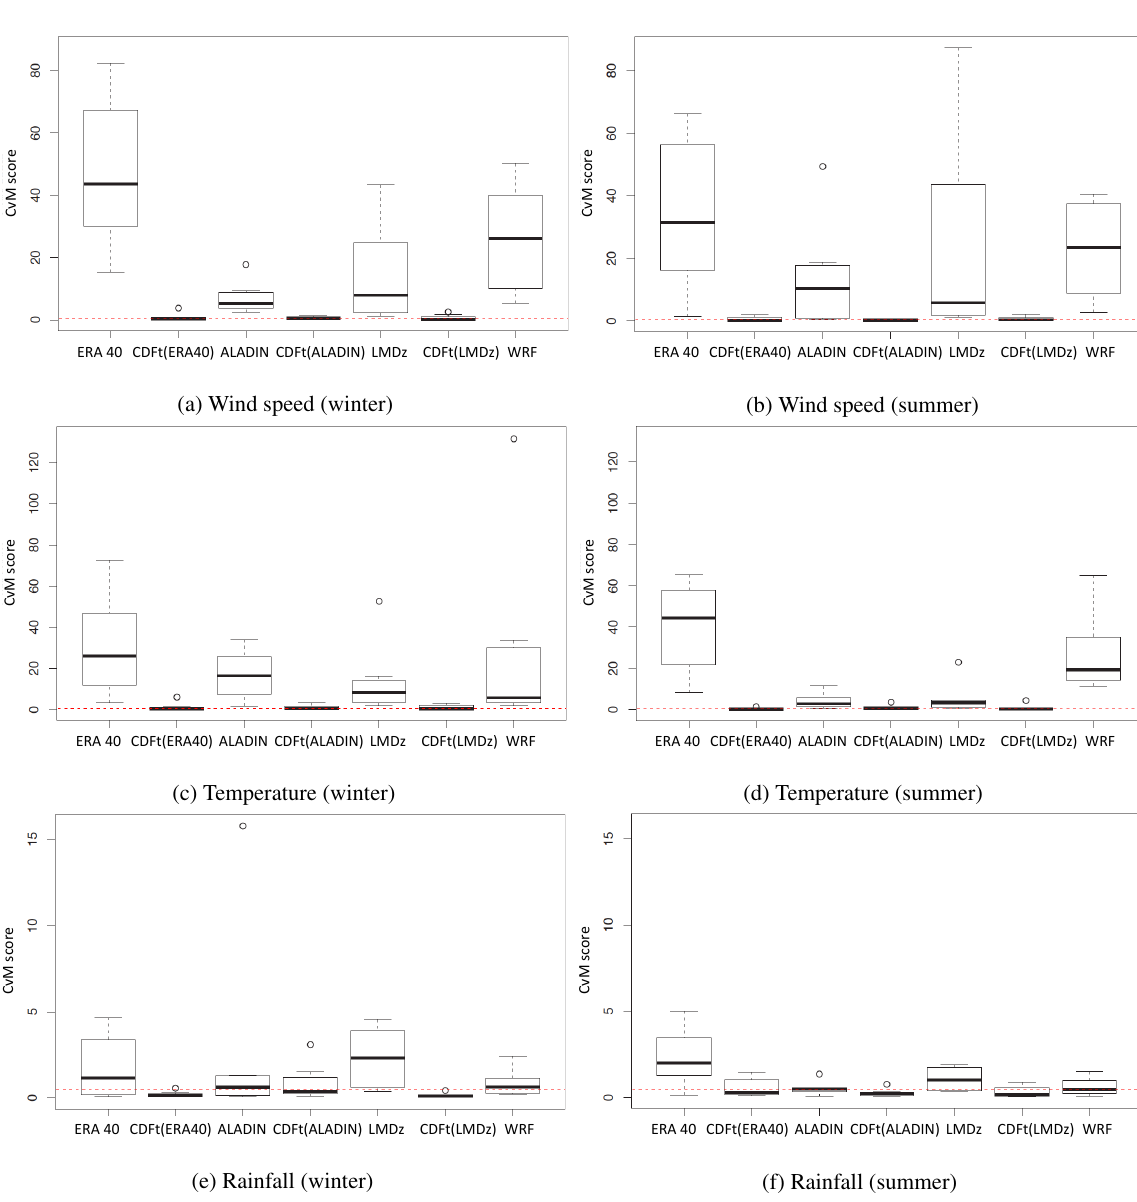
Fig. 2. Boxplots of Cramer-von Mises (CvM) scores computed over the evaluation period (1996–2000 for wind, and 1991–2000 for tem- perature and rain) in winter (left column) and summer (right column). The dashed lines indicate the threshold CvM values under which the Fig. 2: Boxplots of Cramer-von Mises (CvM) scores computed over the evaluation period (1996-2000 for wind, and 1991-2000 Fig. 2: Boxplots of Cramer-von Mises (CvM) scores computed over the evaluation period (1996-2000 for wind, and 1991-2000 modelled CDFs (from ERA-40, RCMs or CDF-t) are not statistically significantly different at 95% from the CDF of the observations. Fig. 2: Boxplots of Cramer-von Mises (CvM) scores computed over the evaluation period (1996-2000 for wind, and 1991-2000 Fig. 2: Boxplots of Cramer-von Mises (CvM) scores computed over the evaluation period (1996-2000 for wind, and 1991-2000 for temperature and rain) in winter (left column) and summer (right column). The dashed lines indicate the threshold CvM for temperature and rain) in winter (left column) and summer (right column). The dashed lines indicate the threshold CvM Fig. 2: Boxplots of Cramer-von Mises (CvM) scores computed over the evaluation period (1996-2000 for wind, and 1991-2000 Fig. 2: Boxplots of Cramer-von Mises (CvM) scores computed over the evaluation period (1996-2000 for wind, and 1991-2000 for temperature and rain) in winter (left column) and summer (right column). The dashed lines indicate the threshold CvM for temperature and rain) in winter (left column) and summer (right column). The dashed lines indicate the threshold CvM ALADIN provide lower CvM scores for precipitation than different from the observations), the three RCMs have their values under which the modeled CDFs (from ERA40, RCMs or CDF-t) are not statistically significantly different at 95% from values under which the modeled CDFs (from ERA40, RCMs or CDF-t) are not statistically significantly different at 95% from for temperature and rain) in winter (left column) and summer (right column). The dashed lines indicate the threshold CvM for temperature and rain) in winter (left column) and summer (right column). The dashed lines indicate the threshold CvM boxplots higher than the theoretical thresholds for both sea- for the other variables and all models perform better than values under which the modeled CDFs (from ERA40, RCMs or CDF-t) are not statistically significantly different at 95% from values under which the modeled CDFs (from ERA40, RCMs or CDF-t) are not statistically significantly different at 95% from sons (first two rows of Fig. 2). For rainfall, CvM scores from ERA-40 for both seasons and variables (except LMDZ win- the CDF of the observations. the CDF of the observations. values under which the modeled CDFs (from ERA40, RCMs or CDF-t) are not statistically significantly different at 95% from values under which the modeled CDFs (from ERA40, RCMs or CDF-t) are not statistically significantly different at 95% from CDF-t are still below the thresholds (Fig. 2e and f). However, ter rainfall). Surprisingly, in general, the RCMs seem to pro- the CDF of the observations. the CDF of the observations. this is also true for ALADIN and WRF, even though the vari- duce better downscaled precipitation than temperature and the CDF of the observations. the CDF of the observations. ability of their CvM statistics is larger (except for summer in wind speed, at least using the CvM Fig. 2f, when ALADIN boxplot is smaller than CDF-t box- plot). For both seasons, CvM values for LMDZ rainfall are higher than the thresholds, meaning that rainfall CDFs signif- icantly differ from the observations. Interestingly, WRF and